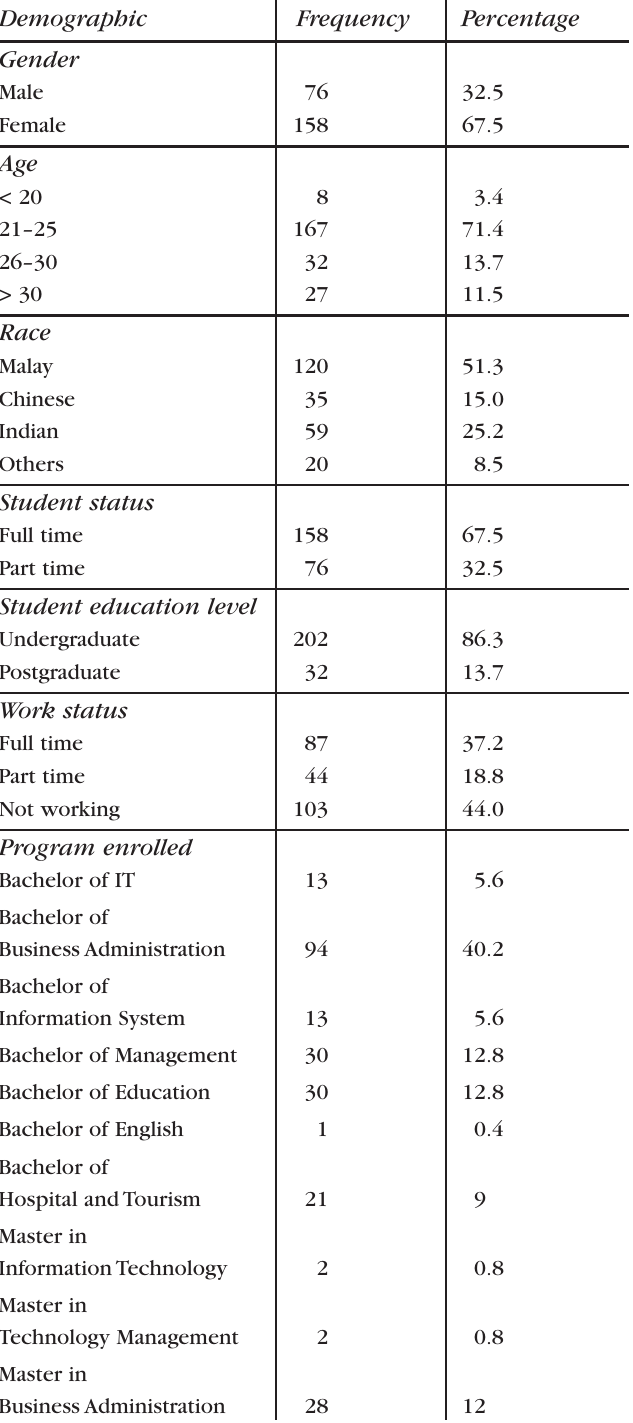
Table 2. Frequency Distributions of Sample (n = 234)